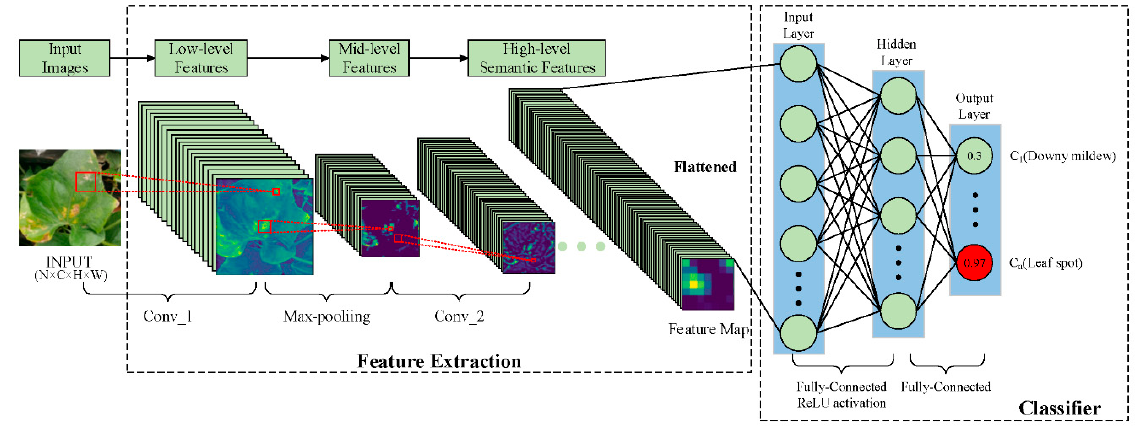
Figure 4. Convolutional neural networks for snake gourd leaf disease classification.